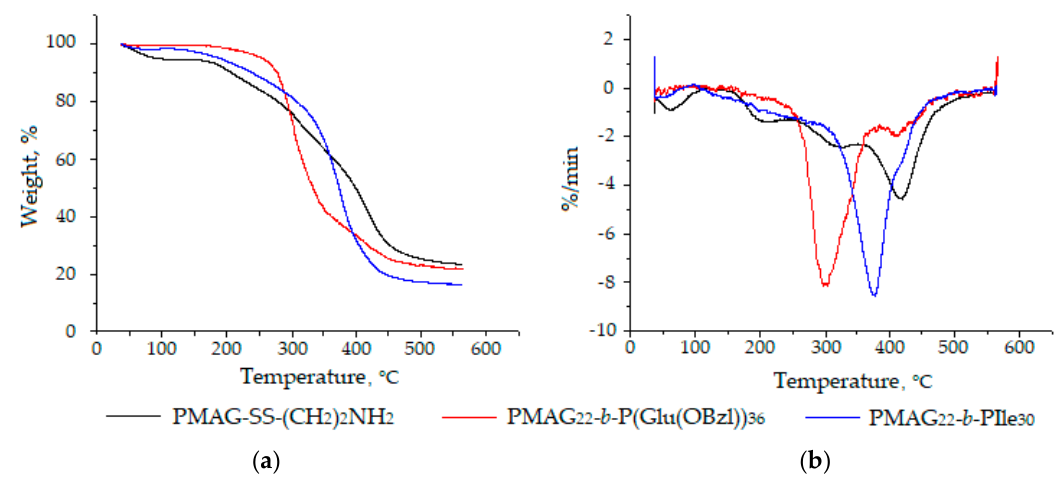
Figure 7. Thermogram ( a ) and differential thermogram ( b ) of PMAG-SS(CH 2 ) 2 NH 2 homopolymer and its copolymers with poly(amino acids).